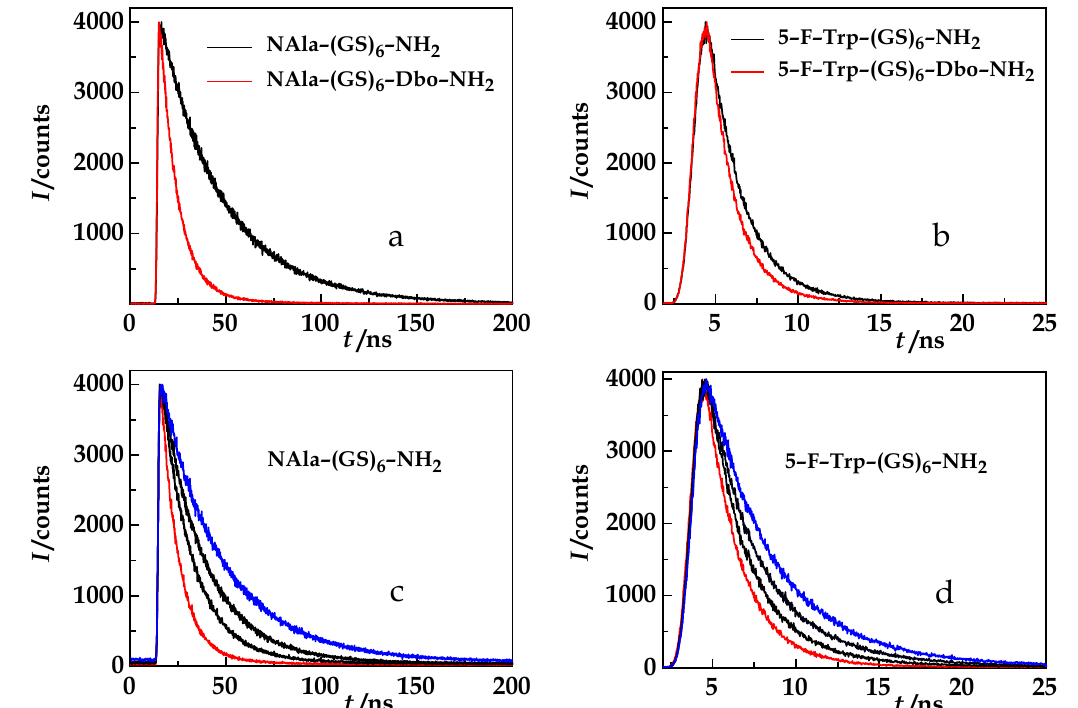
Figure 3. ( a ) NAla sdFRET measurements: Time-resolved fluorescence decays measured with NAla-(GS) 6 -NH 2 (black) and NAla-(GS) 6 -Dbo-NH 2 (red) at 350 nm after excitation at 280 nm in water. The lifetime of the donor-acceptor peptide, τ DA = 10.3 ns, and the lifetime of the donor-only peptide, τ D = 34.7 ns, yield an energy transfer efficiency of 70.4% and an effective distance of 8.5 Å. ( b ) FTrp sdFRET measurements: Time-resolved fluorescence decays measured with 5-F-Trp-(GS) 6 -NH 2 (black) and 5-F-Trp-(GS) 6 -Dbo-NH 2 (red) at 350 nm after excitation at 280 nm in water. The lifetime of the donor-acceptor peptide, 2.0 ns, and the lifetime of the donor-only peptide, 1.5 ns, yield an energy transfer efficiency of 24.7% and an effective distance of 11.5 Å. ( c ) Time-resolved fluorescence decays measured with NAla-(GS) 6 -Dbo-NH 2 and ( d ) 5-F-Trp-(GS) 6 -Dbo-NH 2 at 350 nm after excitation at 280 nm, at ethylene glycol concentrations (vol/vol) ranging from 0% (red) to 92% (blue).